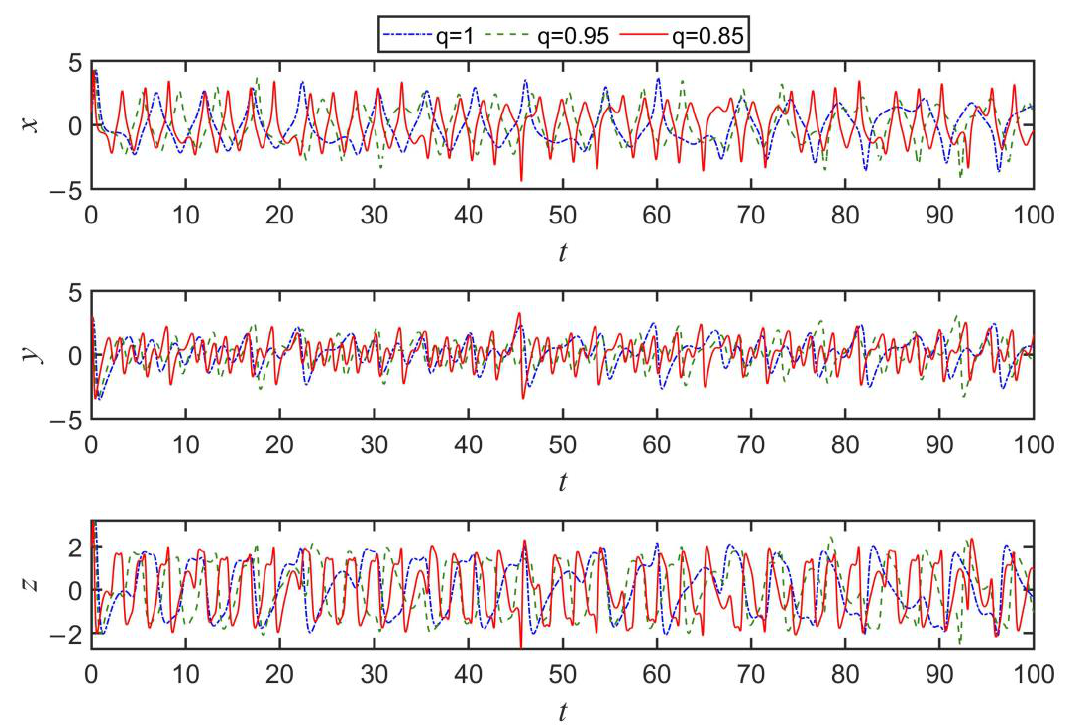
Figure 11. Time series of x , y and z of system (14) with some different orders for a 1 =